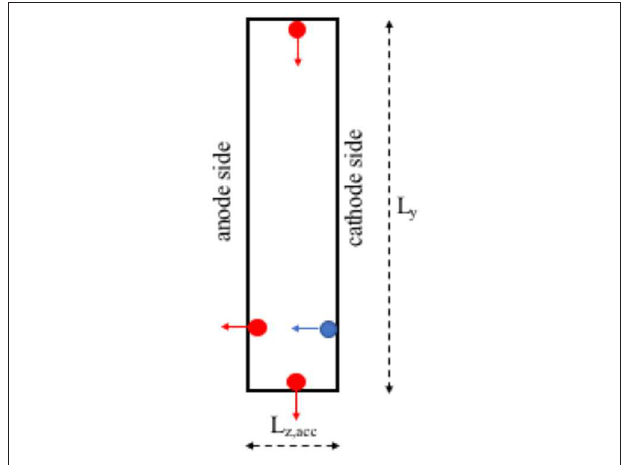
FIGURE 1 | Sketch of the simulation domain used for 1D-azimuthal PIC simulation of HTs. L y is the size of the azimuthal domain, while L z,acc represent the distance traveled by electrons and ions before to be re-injected from the opposite